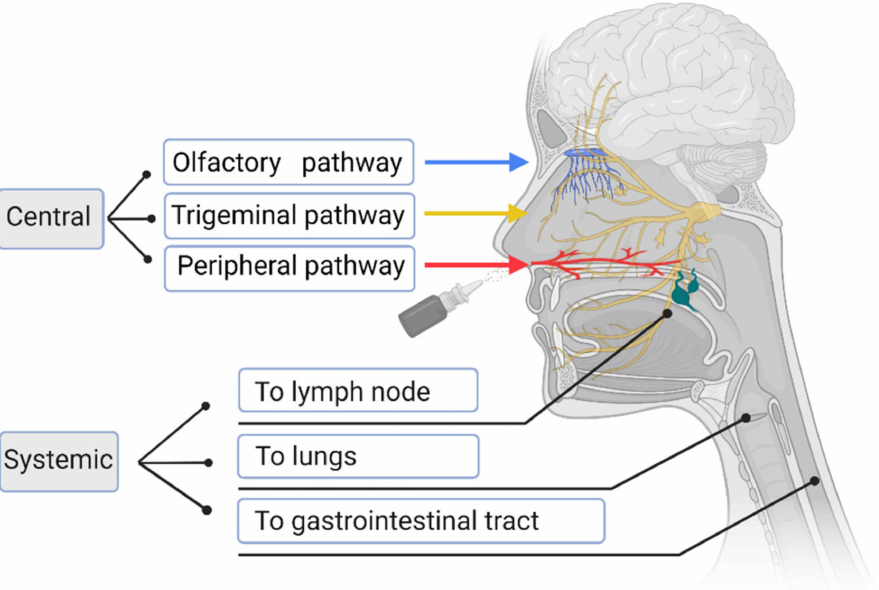
Figure 2. Nasal drug pathways and